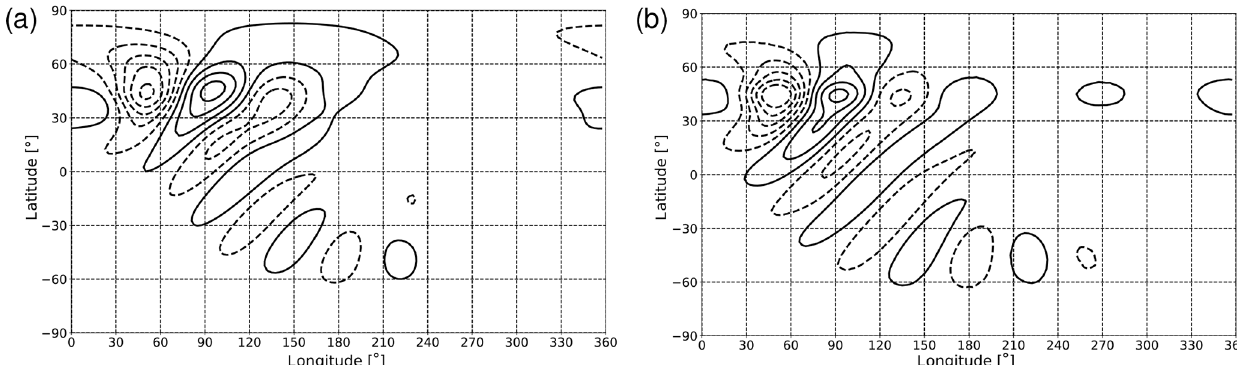
Figure 10. Numerical solution of the stationary part ψ ∗ of the perturbation streamfunction for the weak narrow jet with u J = 10ms − 1 : (a) full nonlinear solution, and (b) pseudo-linear solution. The contours are chosen to be symmetric about zero and the contour interval is 0 . 4 × 10 7 m 2 s − 1 (positive contours solid, negative contours